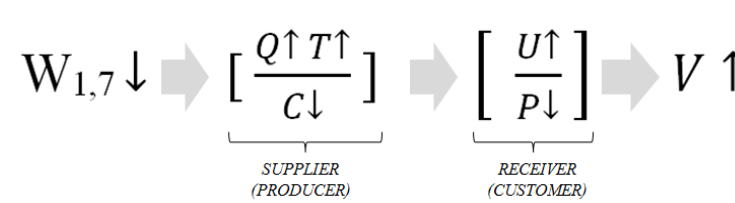
Figure 2. Manufacturing variables in the “Lean”